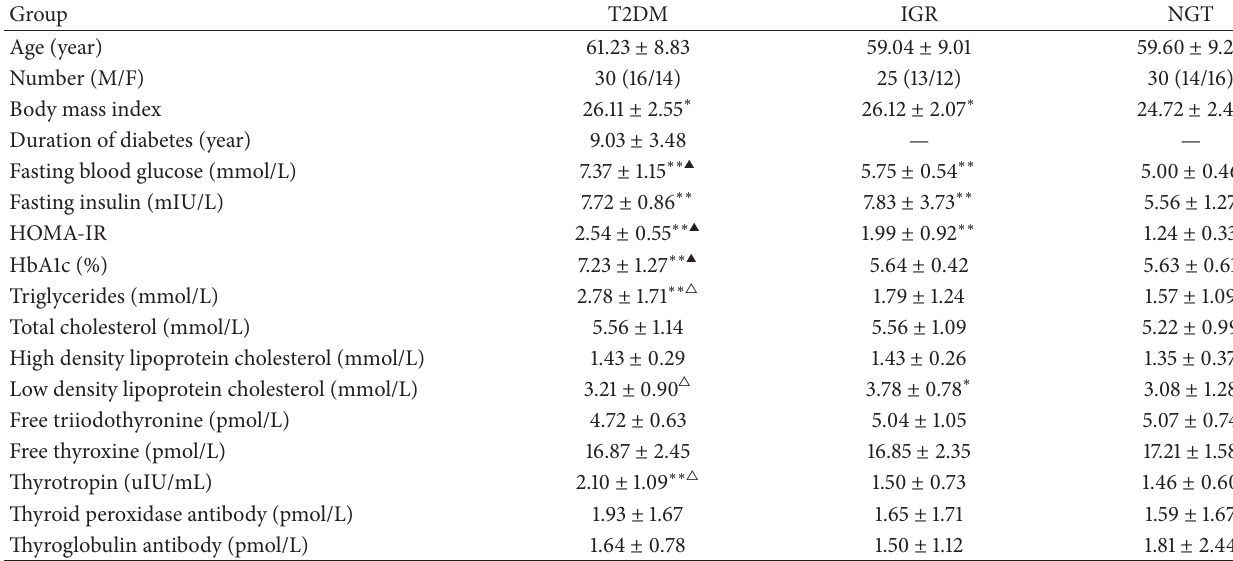
Table 1: Clinical characteristics of the patients ( 𝑥 ± 𝑠 ).